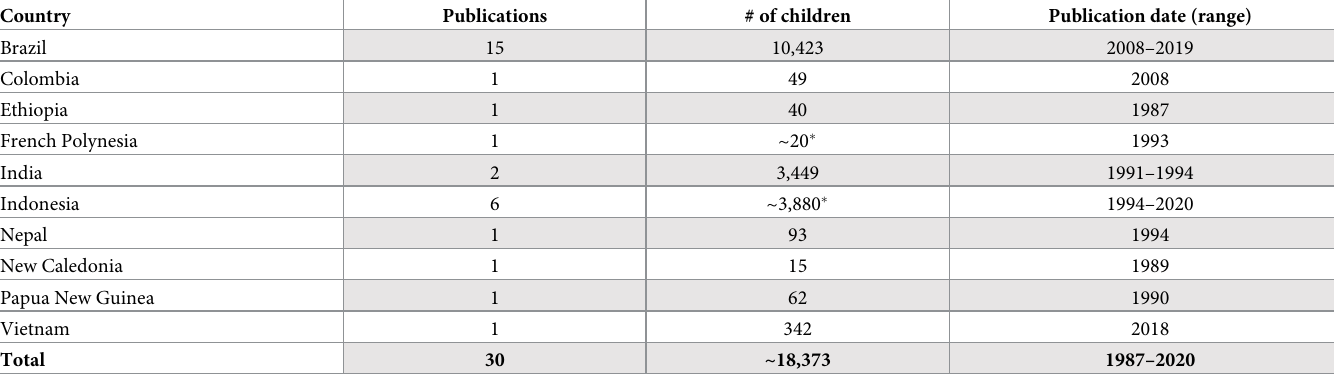
Table 2. Publications on leprosy serology in children without leprosy from ten countries.